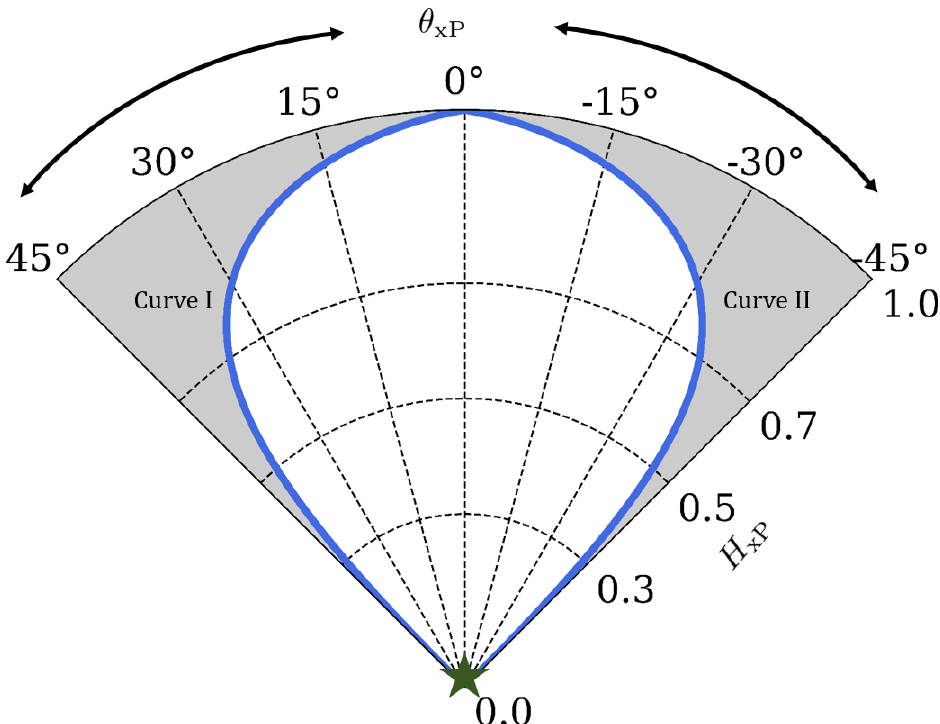
Figure 2. Feasible region of H xP / θ xP plane bounded by two curves (Curve I and Curve II). θ xP is represented in the angular direction and H xP is represented in the radial direction. The non-feasible scattering region is shaded in gray.